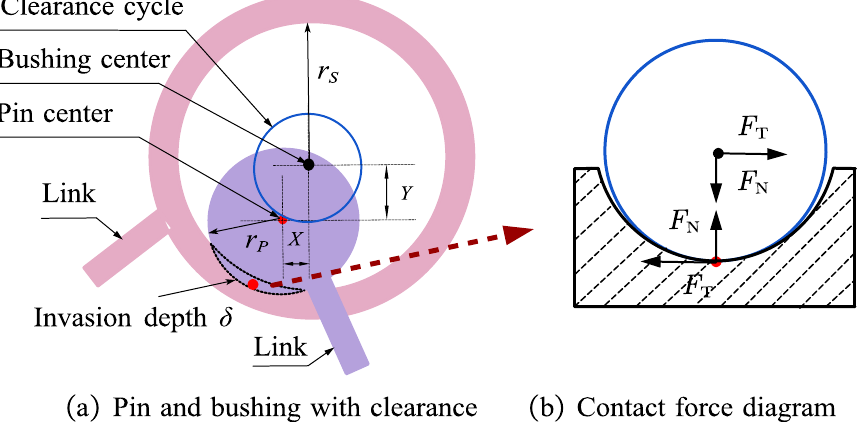
Figure 2. Contact force and contact surface of hinge clearance.